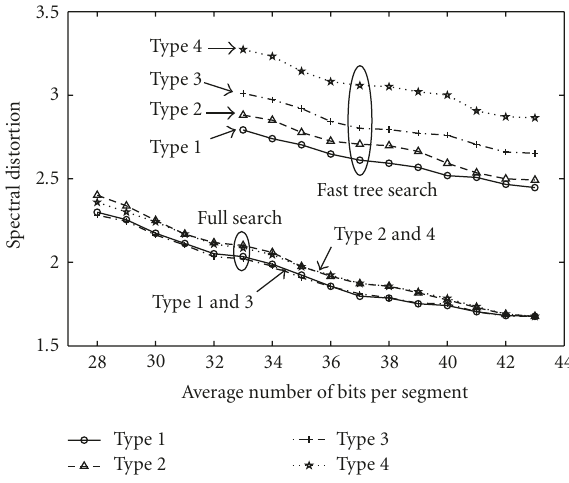
Figure 3: Spectral Distortion (SD) in dB versus average number of bits per segment for four types of accumulated distortion